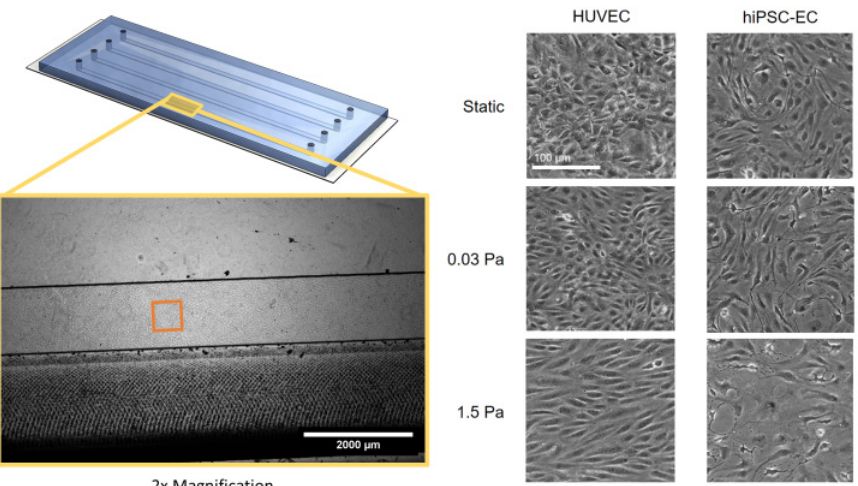
Figure 3. Endothelial cell morphology after 24 h of exposure to specific shear stress in a microfluidic chip channel. HUVEC ( left ) or hiPSC-EC ( right ) were cultured in microfluidic chips until confluent and were subsequently left under static conditions ( top ), treated with flow conditions causing low shear stress ( middle ) or high shear stress ( bottom ). Differences in morphology are shown by representative phase-contrast microscopy images taken after 24 h of culturing under the respective conditions. The scale bar is 100 μ m.